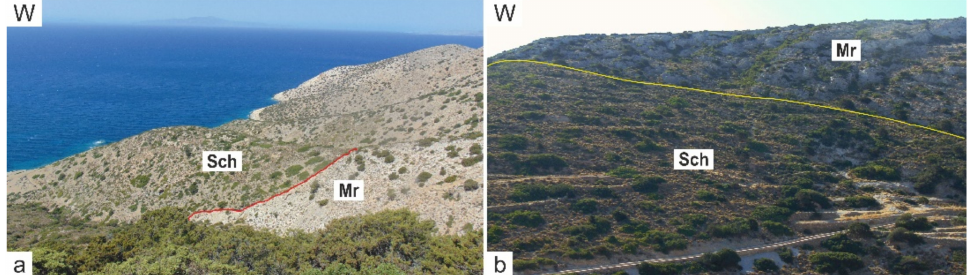
Figure 3. ( a ). View of the Upper Schist Fm. overlying the Marble Fm. (red line) in the SW part of the island (36 ◦ 50 (cid:48) 11 (cid:48)(cid:48) N, 25 ◦ 26 (cid:48) 14 (cid:48)(cid:48) E), ( b ). Main tectonic contact (yellow line) between the Lower Schist and the Marble Fm. from the central part of the island (36 ◦ 49 (cid:48) 57 (cid:48)(cid:48) N, 25 ◦ 27 (cid:48) 2 (cid:48)(cid:48) E).